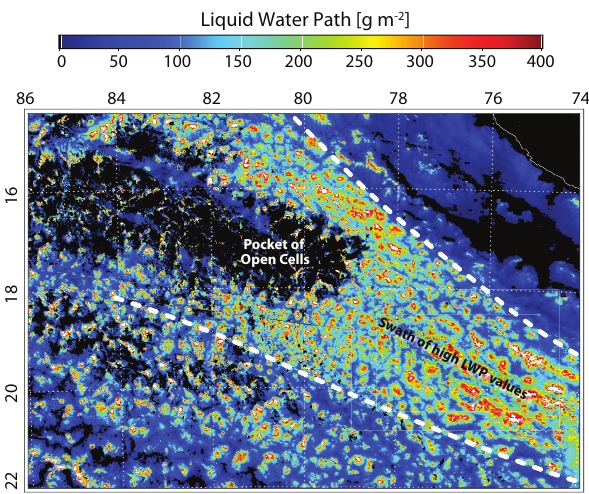
Fig.10. MODIS-estimatedcloudliquidwaterpath(LWP)forthesameoverpass(15:50UTC,28October2008) Fig. 10. MODIS-estimated cloud liquid water path (LWP) for the as shown in Fig. 1. same overpass (15:50UTC, 28 October 2008) as shown in Fig.